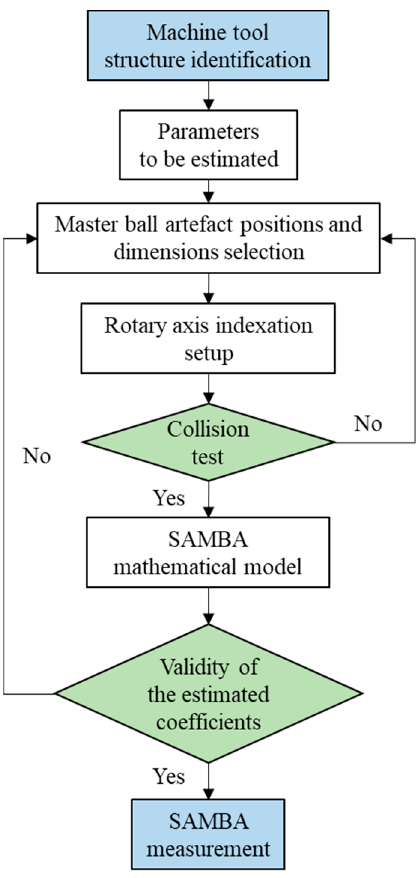
Figure 3. Flowchart of the SAMBA method in its application.